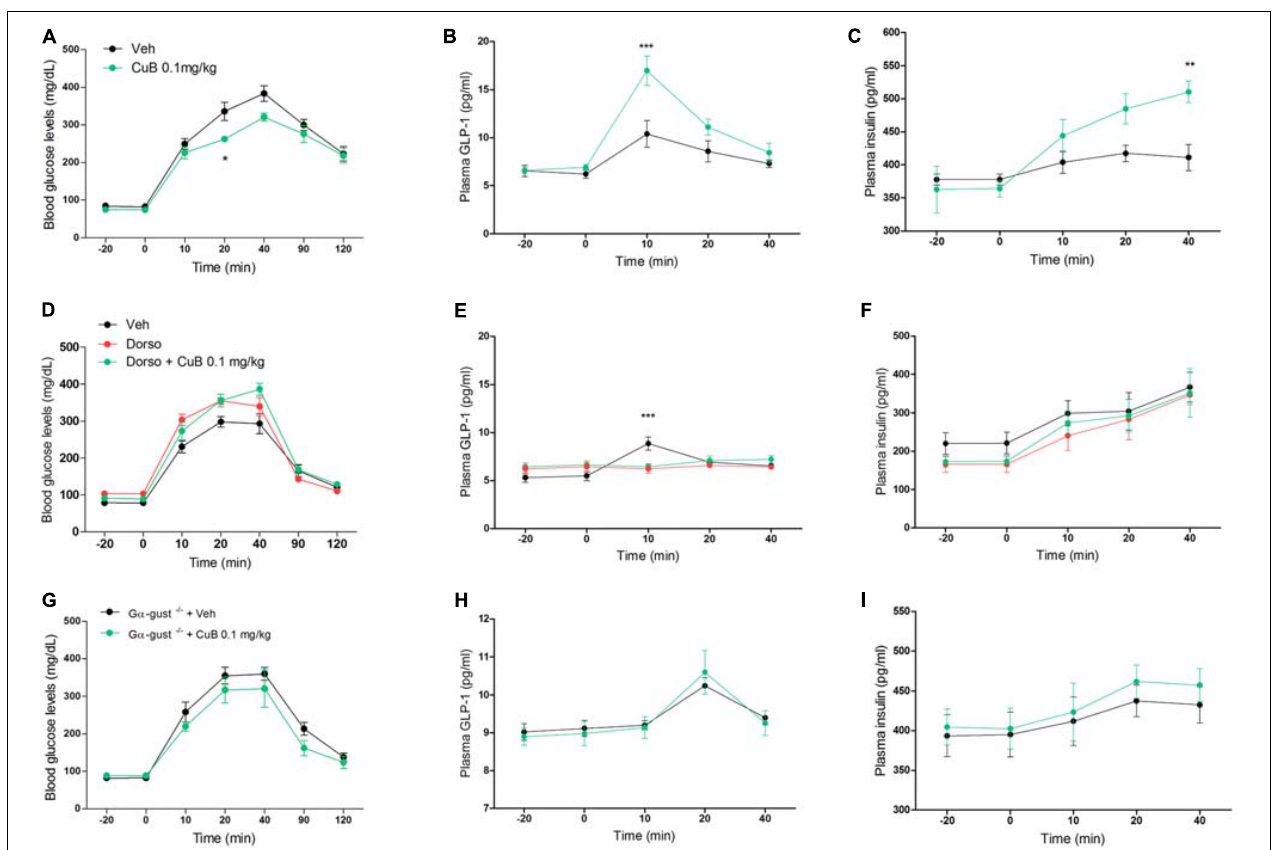
FIGURE 2 | CuB-mediated hypoglycemia is involved in AMPK activation and α -gustducin. (A) Fasted mice were administrated with or without CuB 0.1 mg/kg (Green) and with vehicle (Black) before OGTT. (B,C) After OGTT, plasma GLP-1 and plasma insulin were measured using multiplex system. Data are presented as a Mean ± SEM, n = 8 of the C57bL/6 group treated with or without CuB. ∗∗ P < 0.01, ∗∗∗ P < 0.001 (CuB) vs. vehicle. (D) Fasted mice were injected through i.v with dorso (2 mg/kg), with (Green) or without (Red) 0.1 mg/kg CuB before OGTT. (E,F) After OGTT, plasma GLP-1 and plasma insulin were measured using multiplex system. Data are presented as a Mean ± SEM, n = 7 of the C57BL/6 group treated with or without CuB. ∗∗∗ P < 0.001 (CuB), vs. vehicle. Dorso, Dorsomorphin. (G) Fasted mice of G α -gust − / − mice were administrated with CuB 0.1 mg/kg (Green) and with vehicle (Black) just before OGTT. (H,I) After OGTT, plasma GLP-1 and plasma insulin were measured using multiplex system. Data are presented as a Mean ± SEM, n = 5 of the male G α -gust − / − group treated with or without CuB. The blood glucose levels were measured using Acu-Check performa in end of